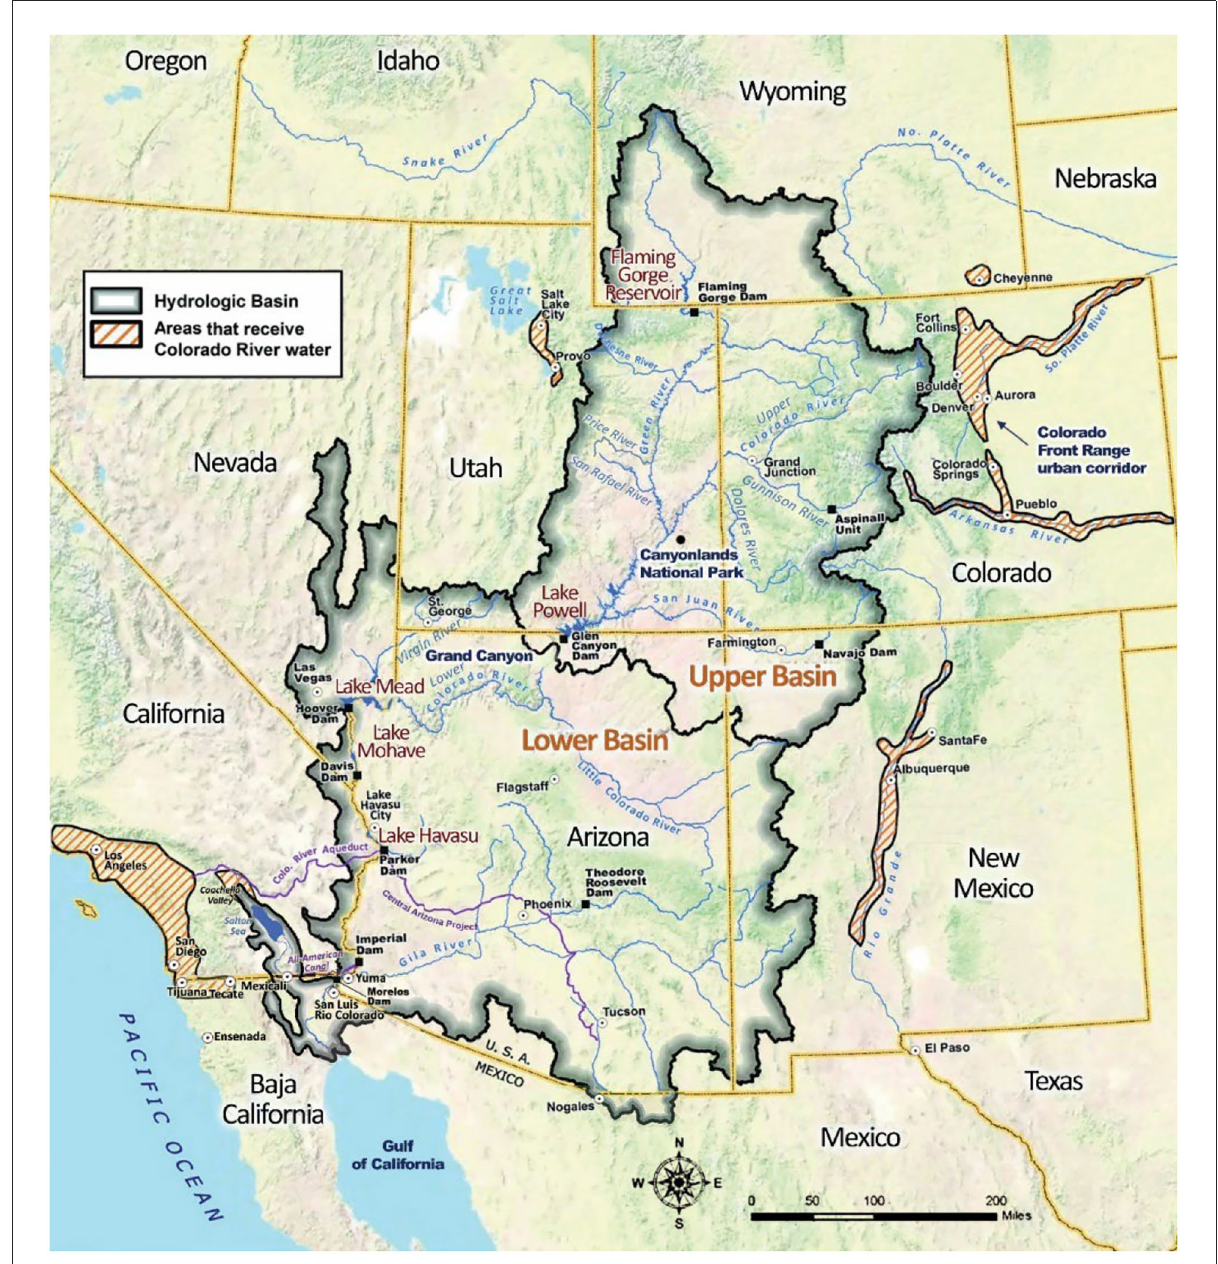
FIGURE1 Map of the Colorado River basin region (Courtesy of: J.C. Schmidt, Center for Colorado River Studies, Utah State University,